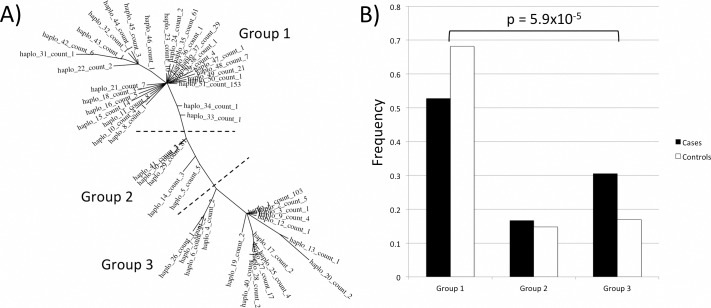
Haplotypes in the chromosome 11 candidate region.(A) Phylogenetic tree displaying haplotype relationship of 15 SNPs in the candidate region on chromosome 11. The 51 haplotypes can be formed into three groups based on the tree clusters (separated by dashed lines). (B) Case/control frequencies in the three haplotype groups in the ESS cohort. There is a lower proportion of cases in haplotype group 1 compared to group 3.